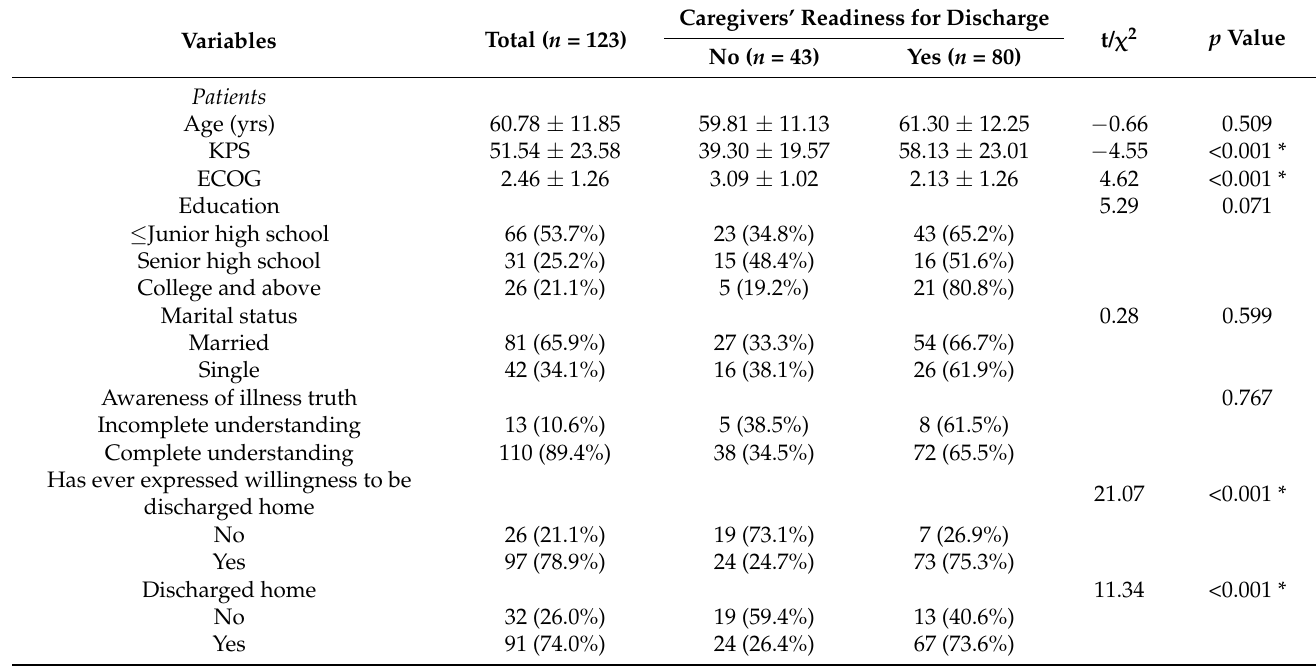
Table 1. Demographic characteristics and family caregivers’ readiness for